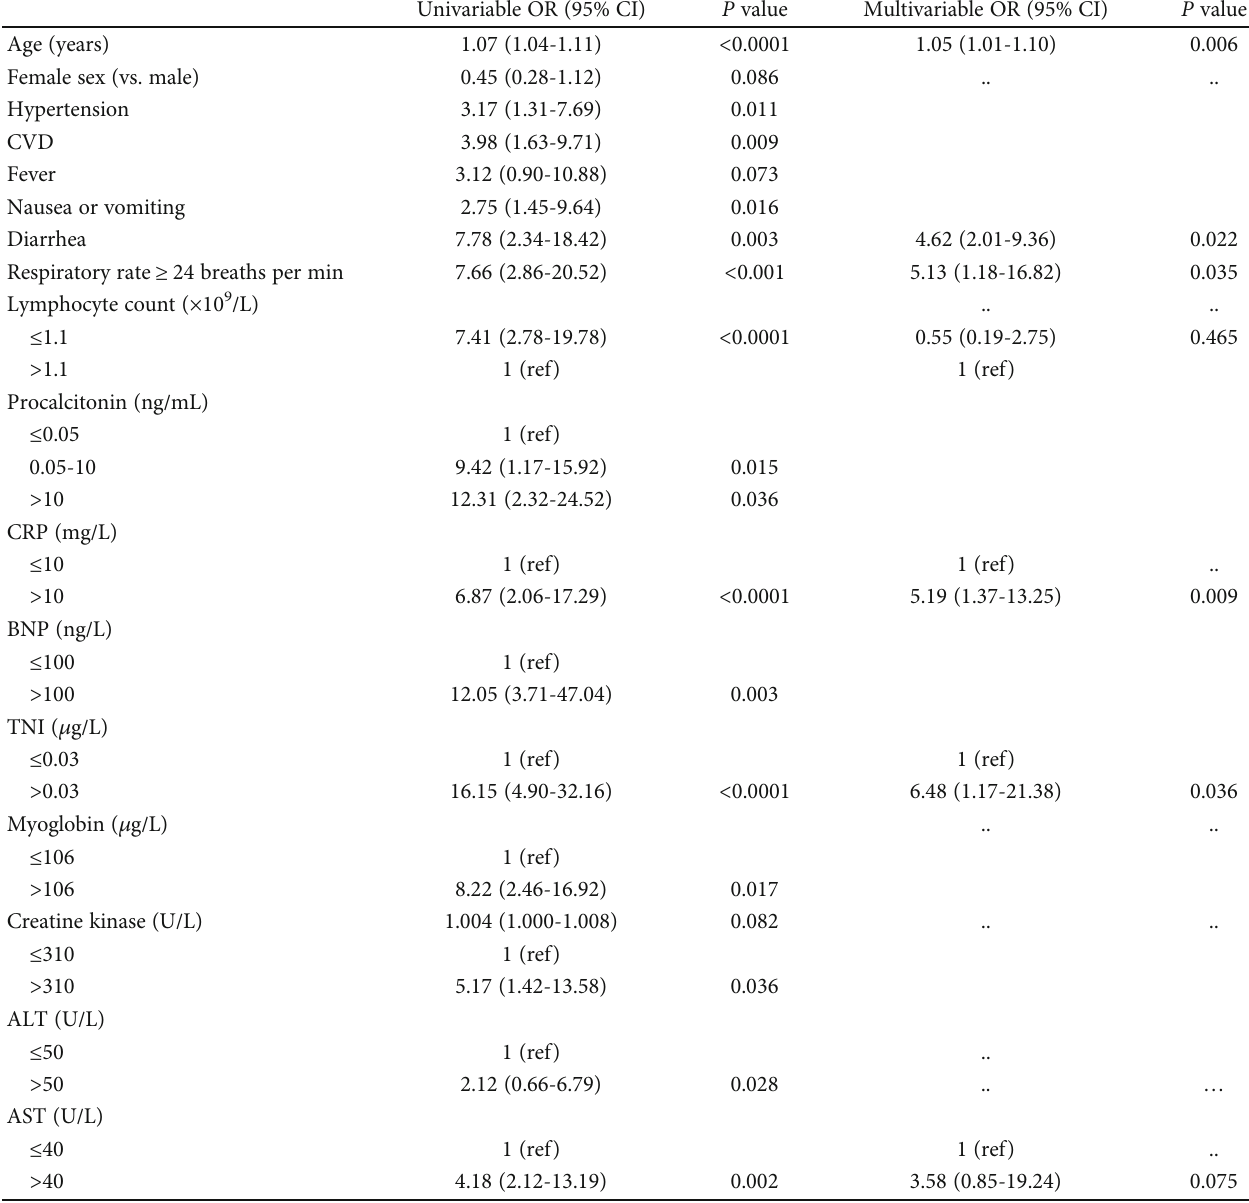
Table 4: Risk factors of ICU admission for COVID-19 patients with